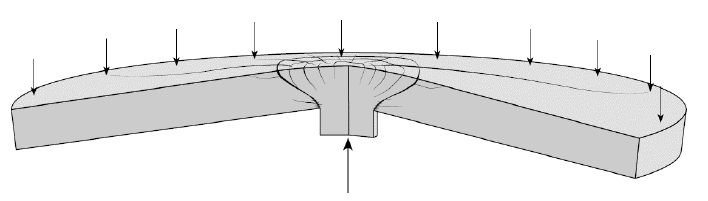
Figure 1. Punching shear failure of flat slab.